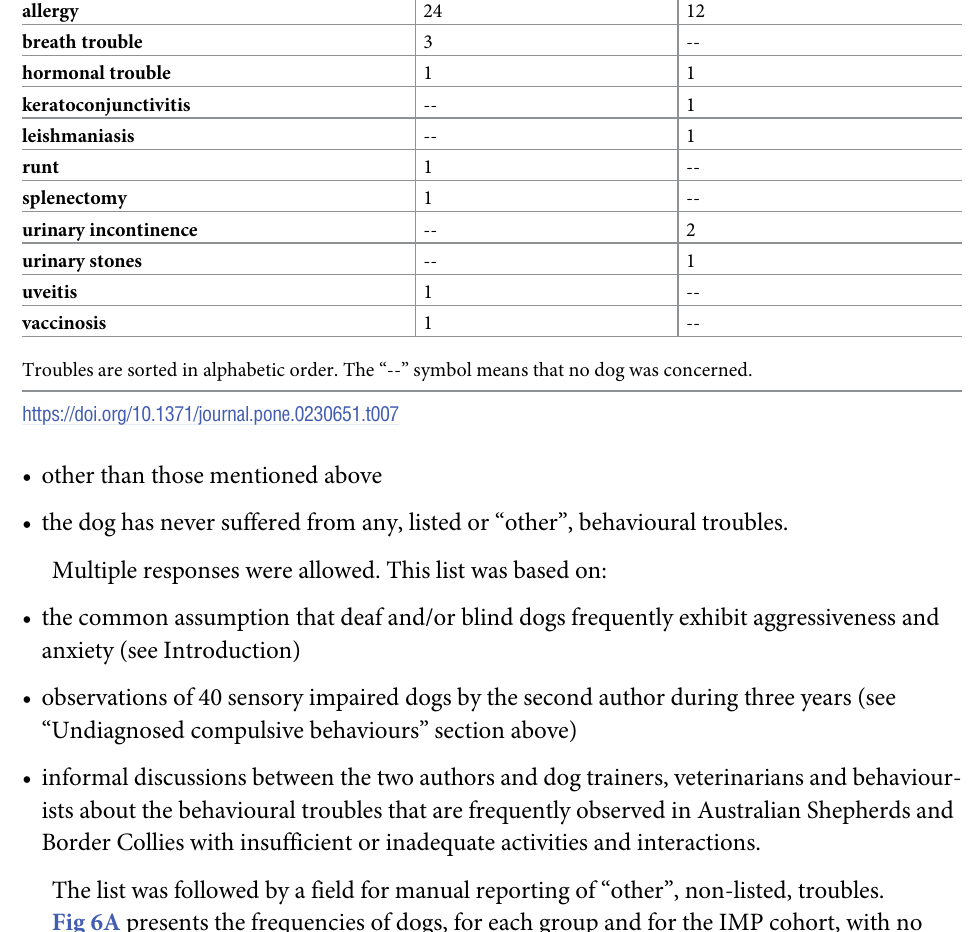
Table 7. Raw numbers of IMP and HNVN dogs for each “other” (non-listed) health trouble as manually reported by owners. IMP